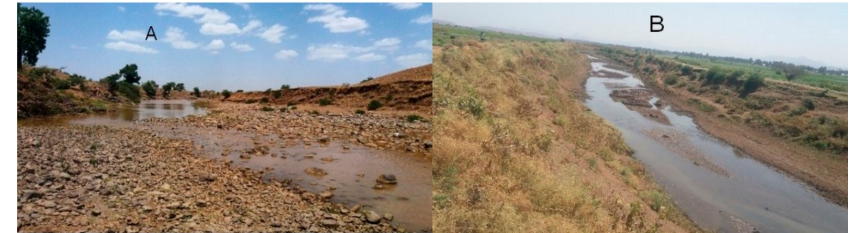
Figure 6. River bed and bank material in the Upper-I ( A ) and the Lower Middle ( B ) River reaches (March 2016).